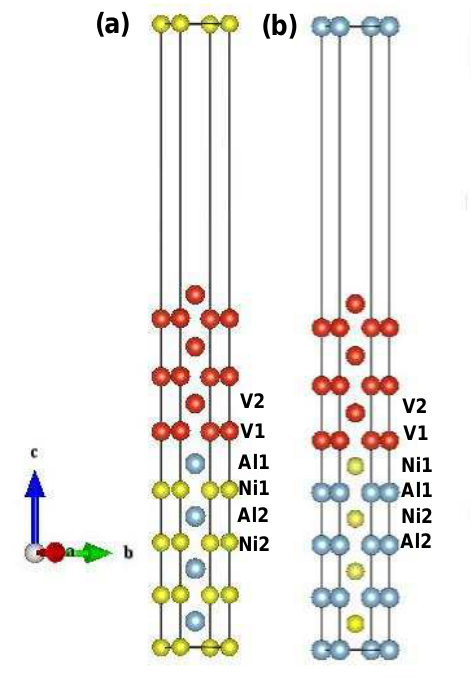
Figure 1. The supercell models for the ( a ) NiAlV and ( b ) AlNiV